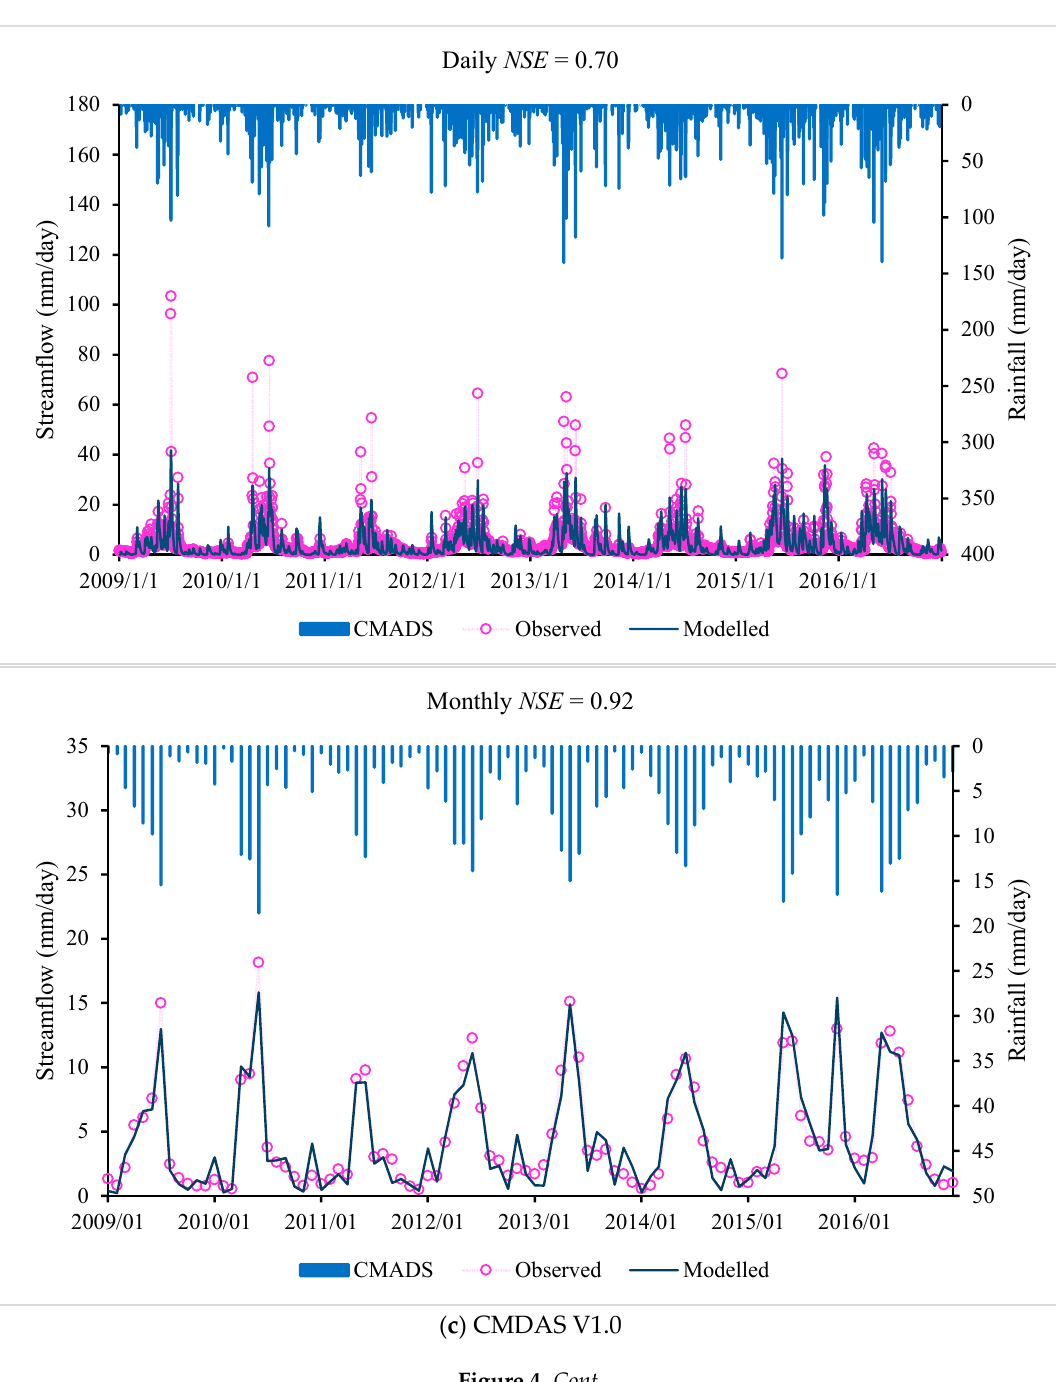
Figure 4. Observed and Sacramento-model-simulated daily and monthly runoffs for ( a ) Gauge- interpolated, ( b ) TMPA-3B42V7 and ( c ) CMDAS rainfall datasets (for the Sacramento model calibrated using NSE as the objective function).